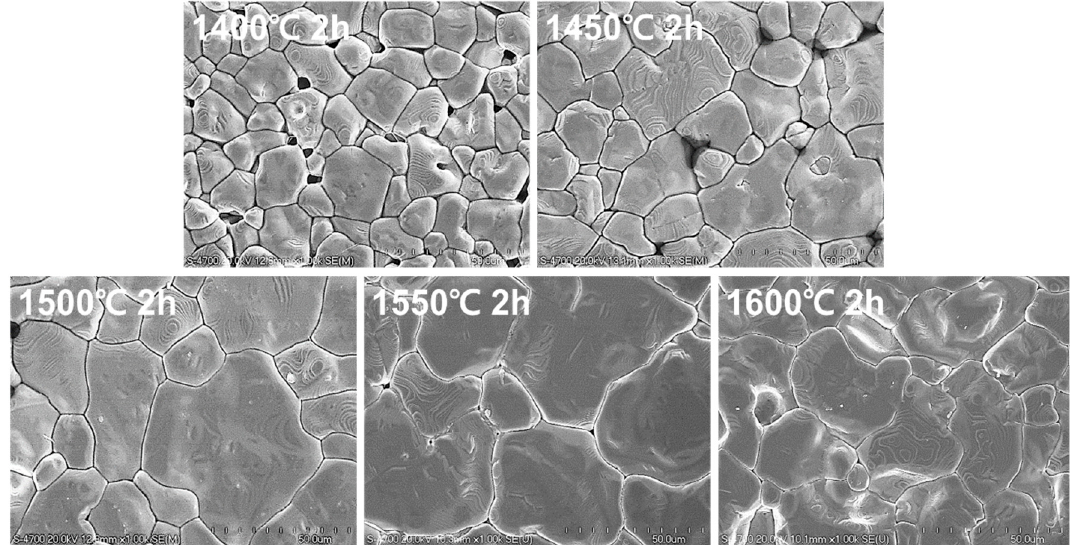
Figure 2. Surface FE-SEM images of the BCTZC0.25 ceramics sintered at different